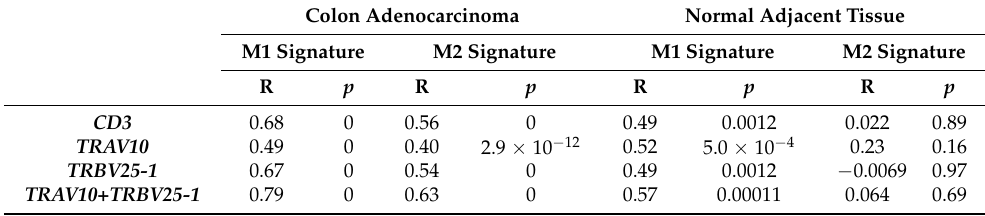
Table 1. The Cancer Genome Atlas Program expression data analysis for the correlation between iNKT cells signature and M1- or M2-like macrophages signatures on colon adenocarcinoma and normal adjacent tissue. Colon Adenocarcinoma Normal Adjacent Tissue M1 Signature